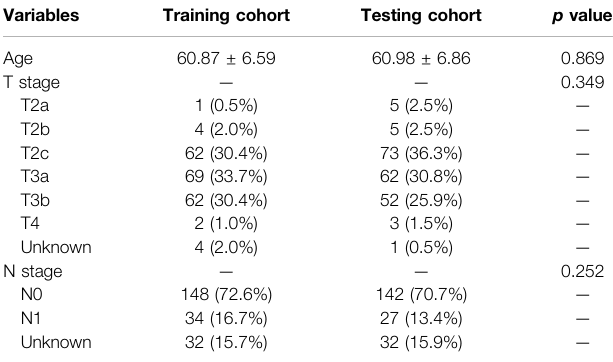
TABLE 1 | Comparison of baseline data between training and testing